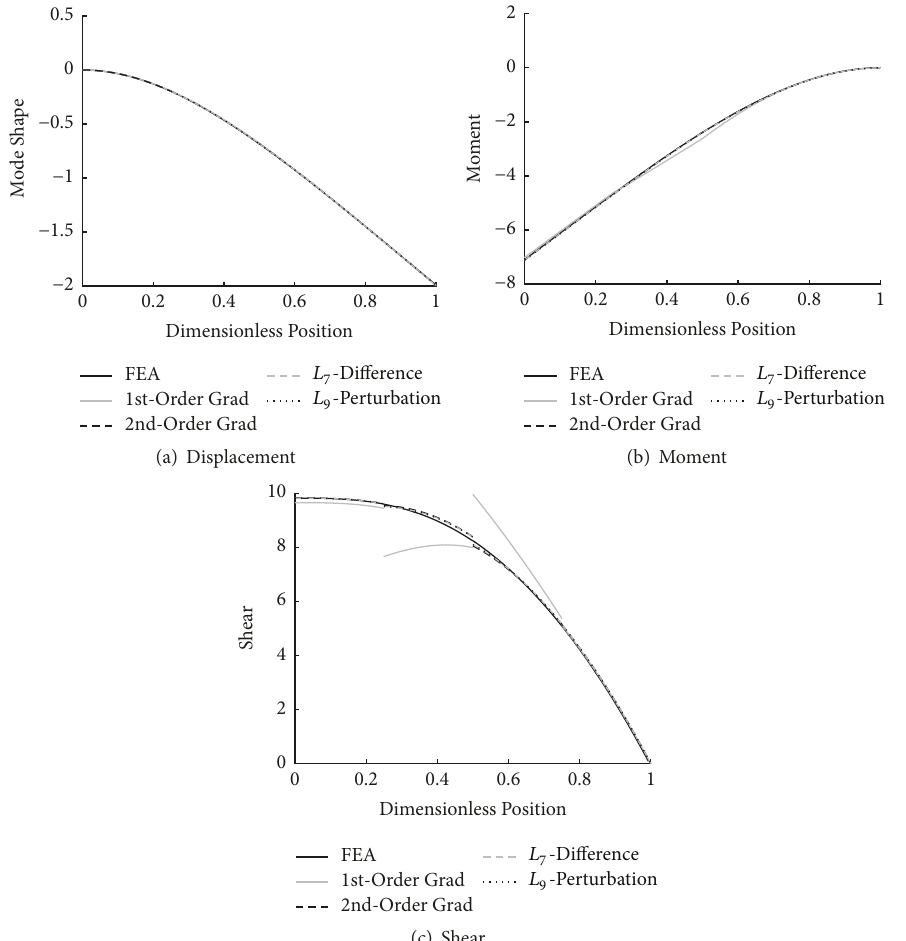
Figure 12: Mode shape displacement, moment, and shear for clamped-free boundary